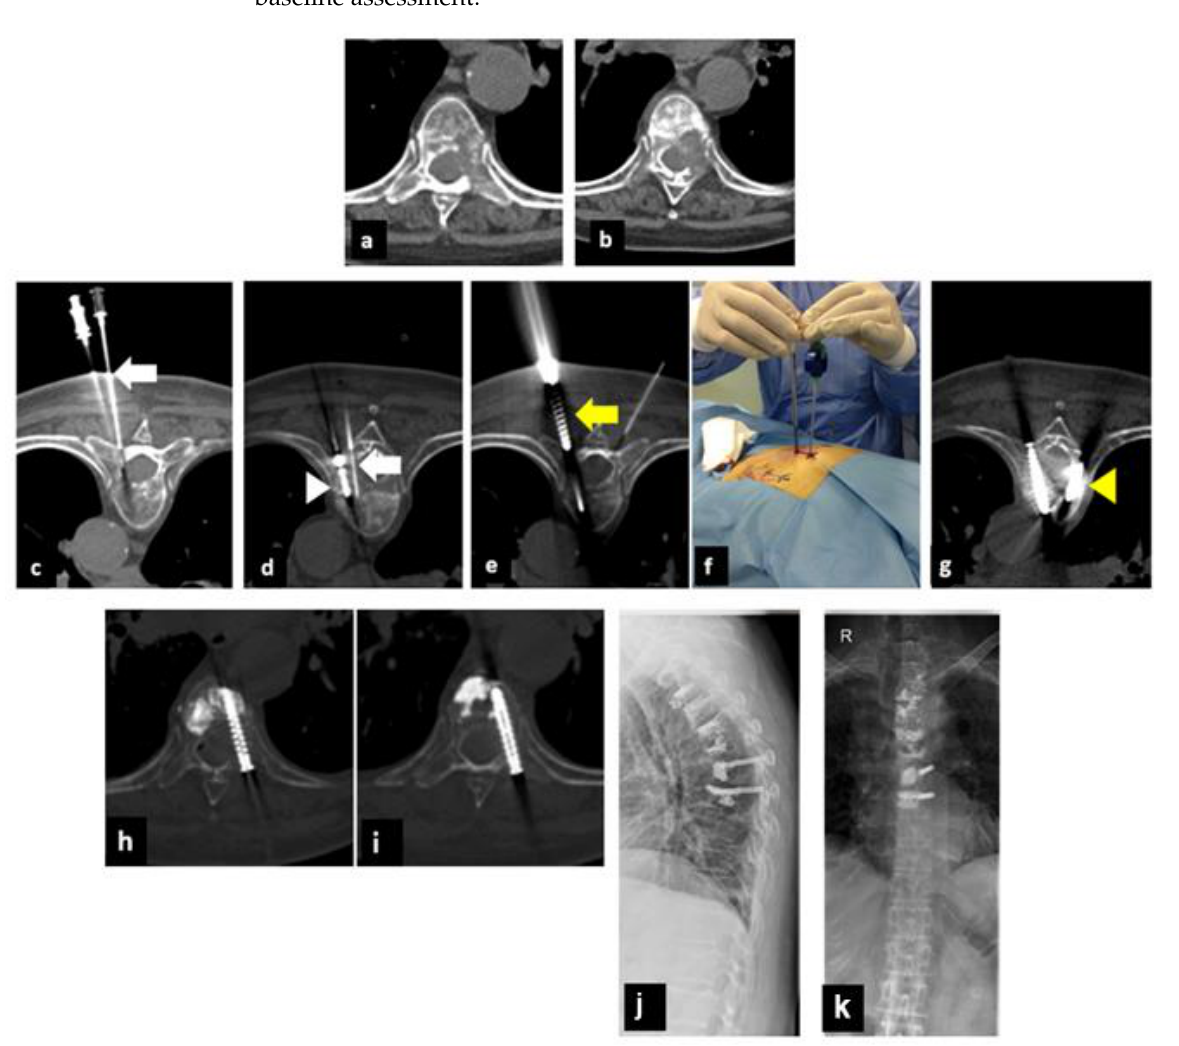
Figure 1. A 67-year-old woman with a history of non-small cell lung cancer, previously treated with multiple dorsal vertebroplasties for pathological vertebral fractures. ( a , b ): Axial CT shows extensive osteolytic metastases of the D7 and D8 vertebral bodies that involved the right pedicle in both cases. ( c , d ): Axial CT shows thermocouple placement (white arrows) and thermal ablation with MW (arrowhead). ( e , f ): Axial CT scan and intraoperative image ( f ) show the positioning of the screw (yellow arrow). ( g ): Axial CT scan shows contralateral placement of the vertebroplasty cannula. h-i-l-m: Axial CT scan shows post-procedure control ( h , i ) and a radiograph of the thoracolumbar spine at 3 months in antero-posterior and latero-lateral projection ( j , k ) after microwave ablation combined with pedicle screw fixation followed by vertebroplasty